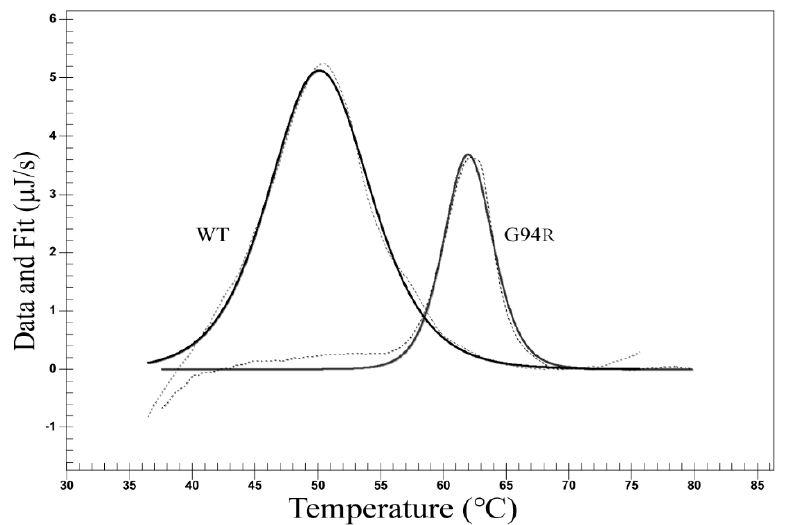
Figure 6. Differential scanning calorimetry (DSC) analysis on antibody stability. The dissolution temperature (Tm) of the WT and mutant scFvs (G94R) were 50.20 °C and 61.98 °C, respectively. The dashed line shows the raw data, and the solid line shows the fitting curve.